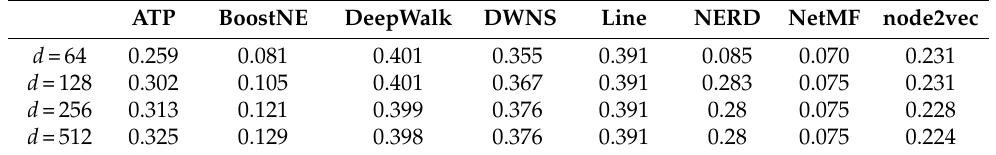
Table A2. Precision values of all embedding methods with the Cora dataset and different values of d . ATP